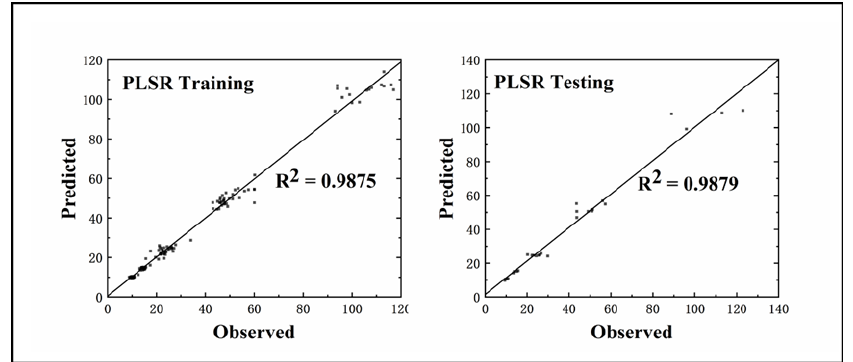
Figure 1. Training ( left ) and testing ( right ) accuracy of special skills assessment results of observed and predicted from the PLSR model in the firefighters.